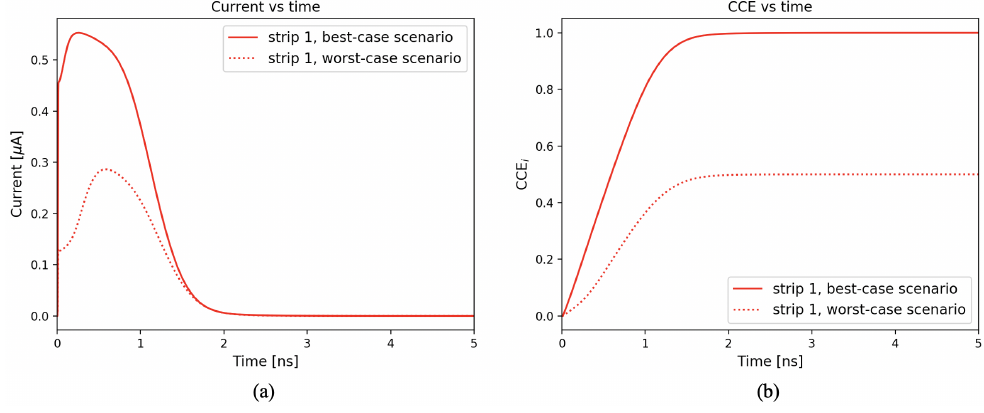
Figure 10. Simulated current signals ( a ) and corresponding charge collection efficiency CCE i ( b ) in the best-case and worst-case scenarios for strip number 1 in an example 50 µ m thick microstrip domain. A particle track with an Linear Energy Transfer (LET) of 1.28 × 10 − 5 pC/ µ m was